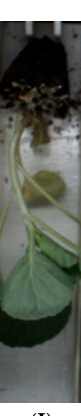
Figure 4. Experimental pictures in the excess green color space. ( І ) The original image. ( A ) The image in the excess green color space.